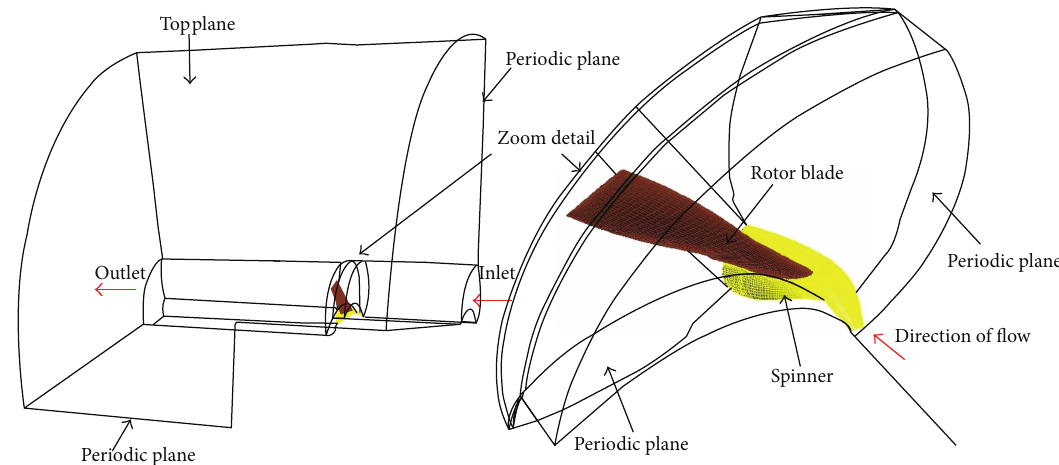
Figure 2: Full computational domain showing the rotor blade and the spinner and the boundary conditions.